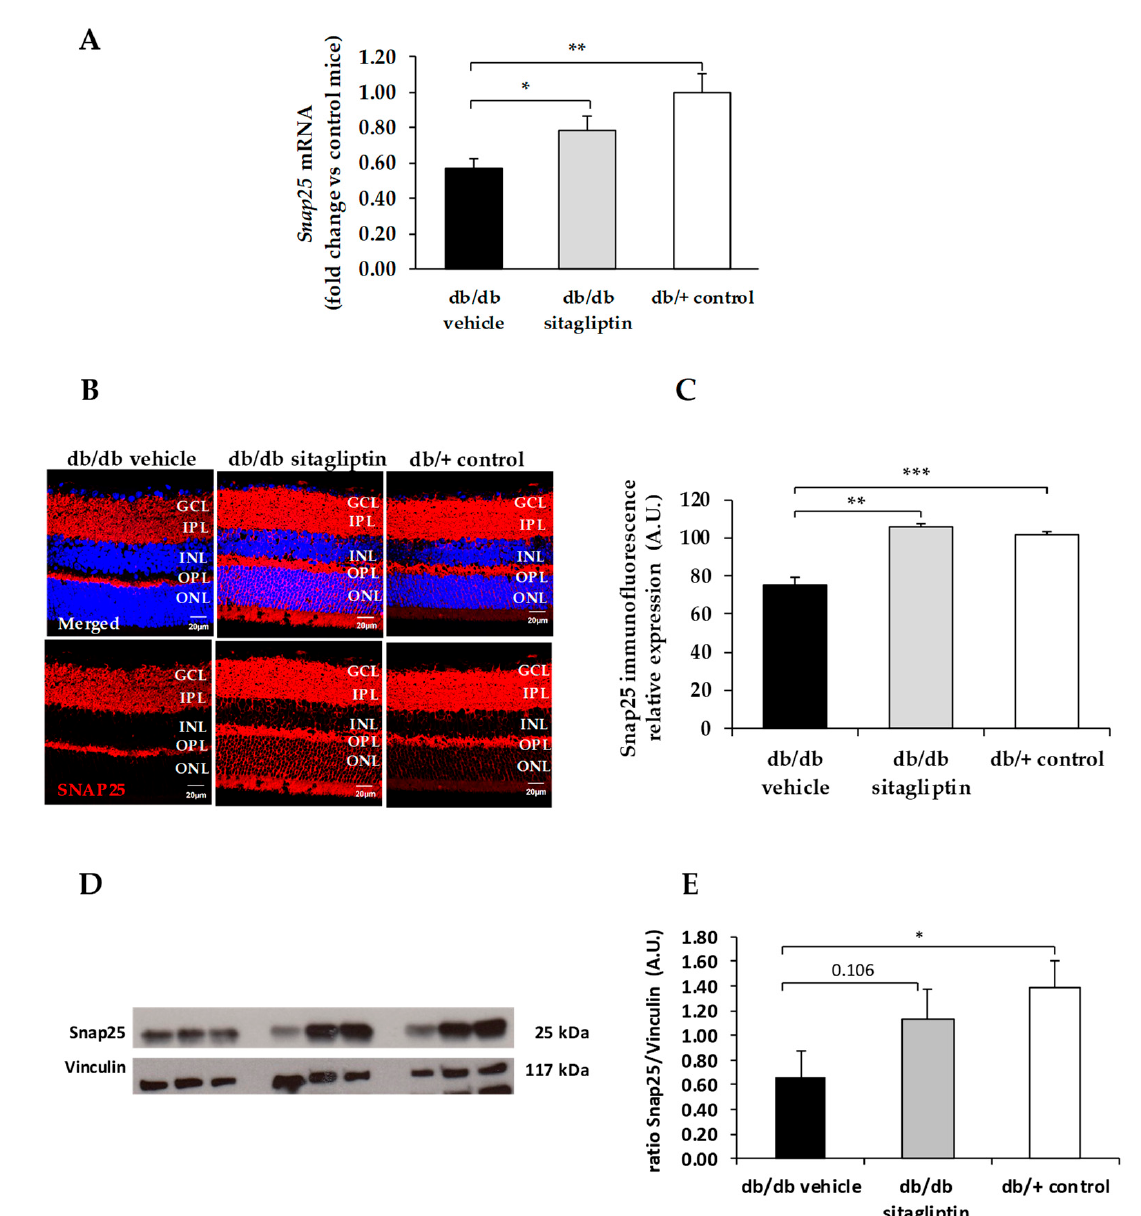
Figure 6. ( A ) Real-time quantitative RT-PCR analysis of SNAP25 gene (Snap25) in db/db mice treated with vehicle (black bars), sitagliptin eye drops (grey bars), and in non-diabetic mice (white bars). ( B ) Immunofluorescence of SNAP25 (red) among representative samples of diabetic retinas of experimental groups. Hoechst staining (blue) was used for nuclei labeling. ONL: outer nuclear layer; OPL: outer plexifom layer; INL: inner nuclear layer; IPL: inner plexiform layer; GCL: ganglion cell layer. Scale bars, 20 µ m. ( C ) Quantification of SNAP25 immunofluoresence in diabetic mice treated with vehicle eye drops (black bars), sitagliptin eye drops (grey bars), and in non-diabetic retinas (white bars). ( D ) Western blot bands of SNAP25 and ( E ) Densitometric analysis in db/db mice treated with vehicle eye drops (black bars), sitagliptin eye drops (grey bars), and in non-diabetic mice retinas (white bars). Protein levels were normalized with vinculin. * p < 0.05, ** p < 0.01, *** p < 0.001.